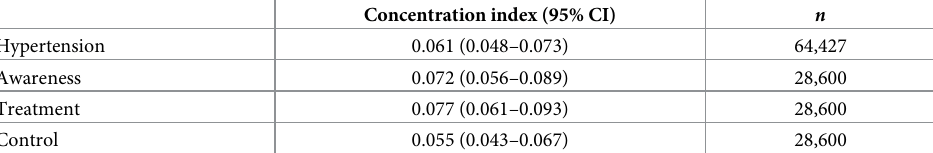
Table 2. Adjusted concentration indices for hypertension and for ATC among those with hypertension, adults aged 45 years and over and their